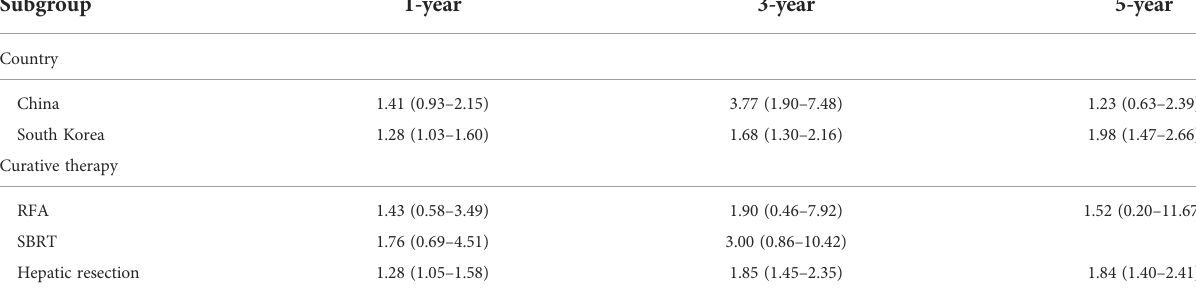
TABLE 3 Subgroup analysis of RFS (OR, 95%